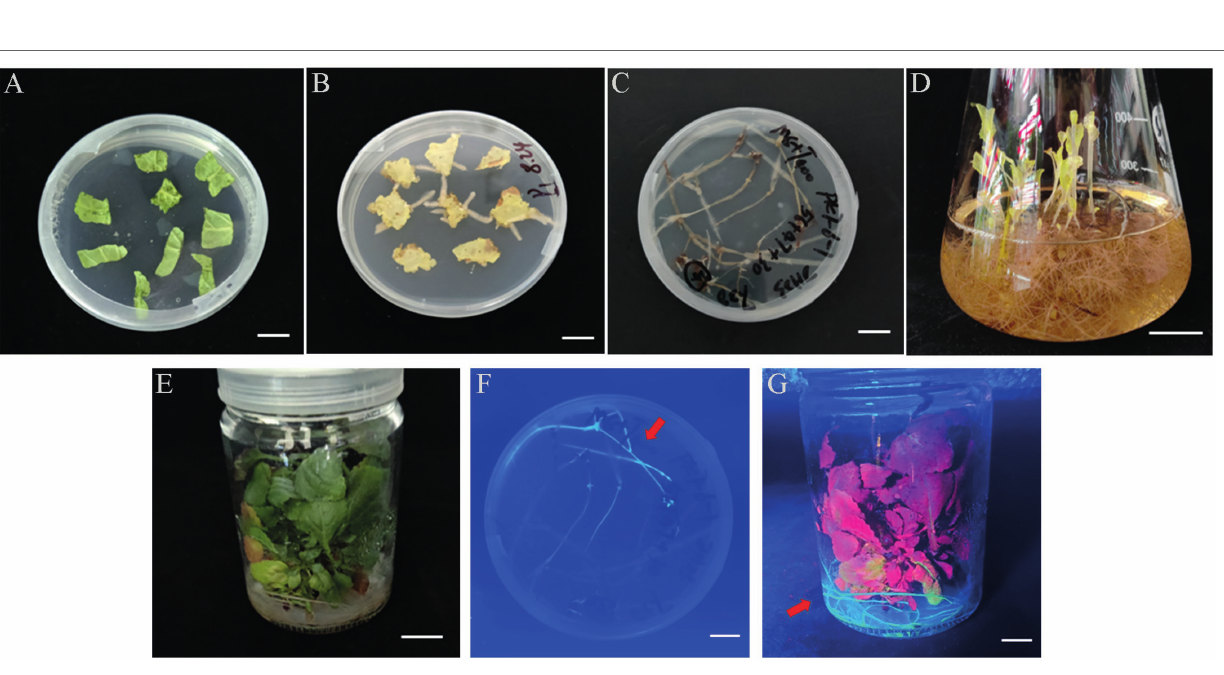
FIGURE 3 | The experimental process of Agrobacterium -mediated transformation in S. miltiorrhiza . (A) Explants. (B) Selected culture. (C) Hairy roots. (D) Root bud appearance. (E) Plant regeneration. (F) Stable GFP expression in transgenic hairy roots. (G) Stable GFP expression in transgenic plant. Bars = 1